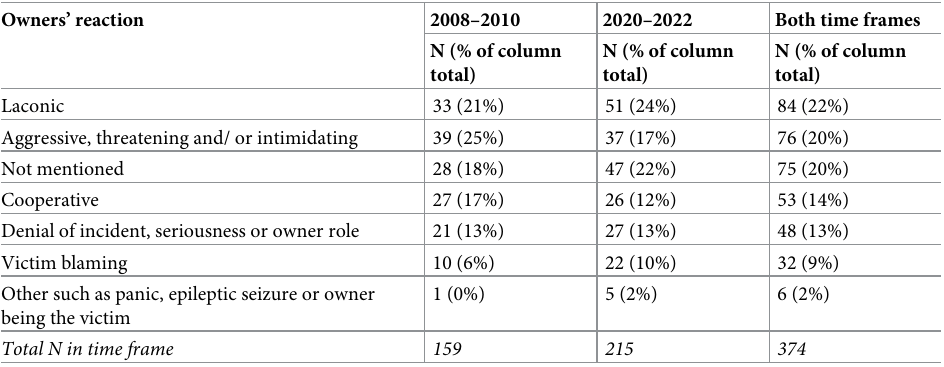
Table 7. Descriptive data on dog owners’ reactions upon their dog’s biting of a human and/ or animal, at biting incidents leading to confiscation of 374 dogs. Descriptive data on dog owners’ reactions upon their dog’s biting of a human and/ or animal, at biting incidents leading to confiscation of 374 dogs, as counts and as % of column total for a first time frame (2008–2010), a second time frame (2020-mid-May 2022) and overall for both time frames. No signifi- cant differences were found between the time frames ( χ 2 = 8.5, P = 0.21, df = 6). Owners’